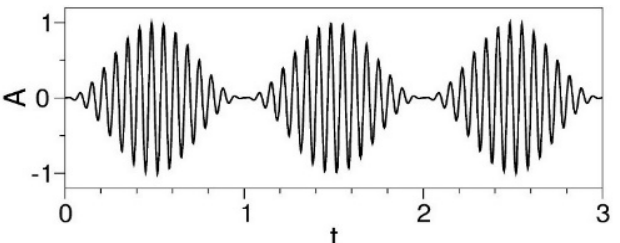
Figure 4. Upstream and downstream facing (deactivated) plasma actuator at 40% chord and plain wing without plasma actuator for Re = 64,200. (Reprinted from [28]).